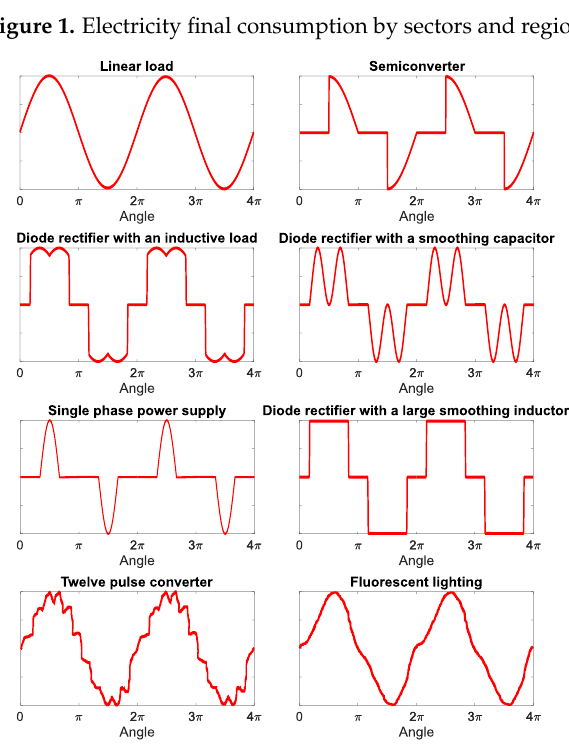
Figure 2. Typical current waveforms